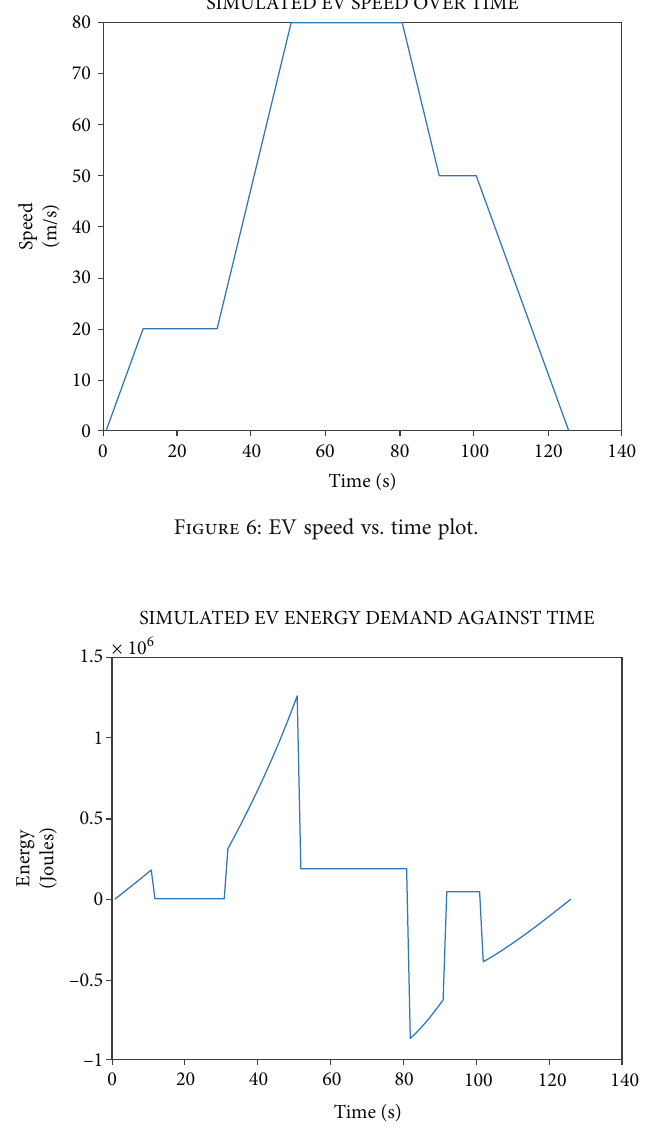
Figure 7: EV energy demand vs. time